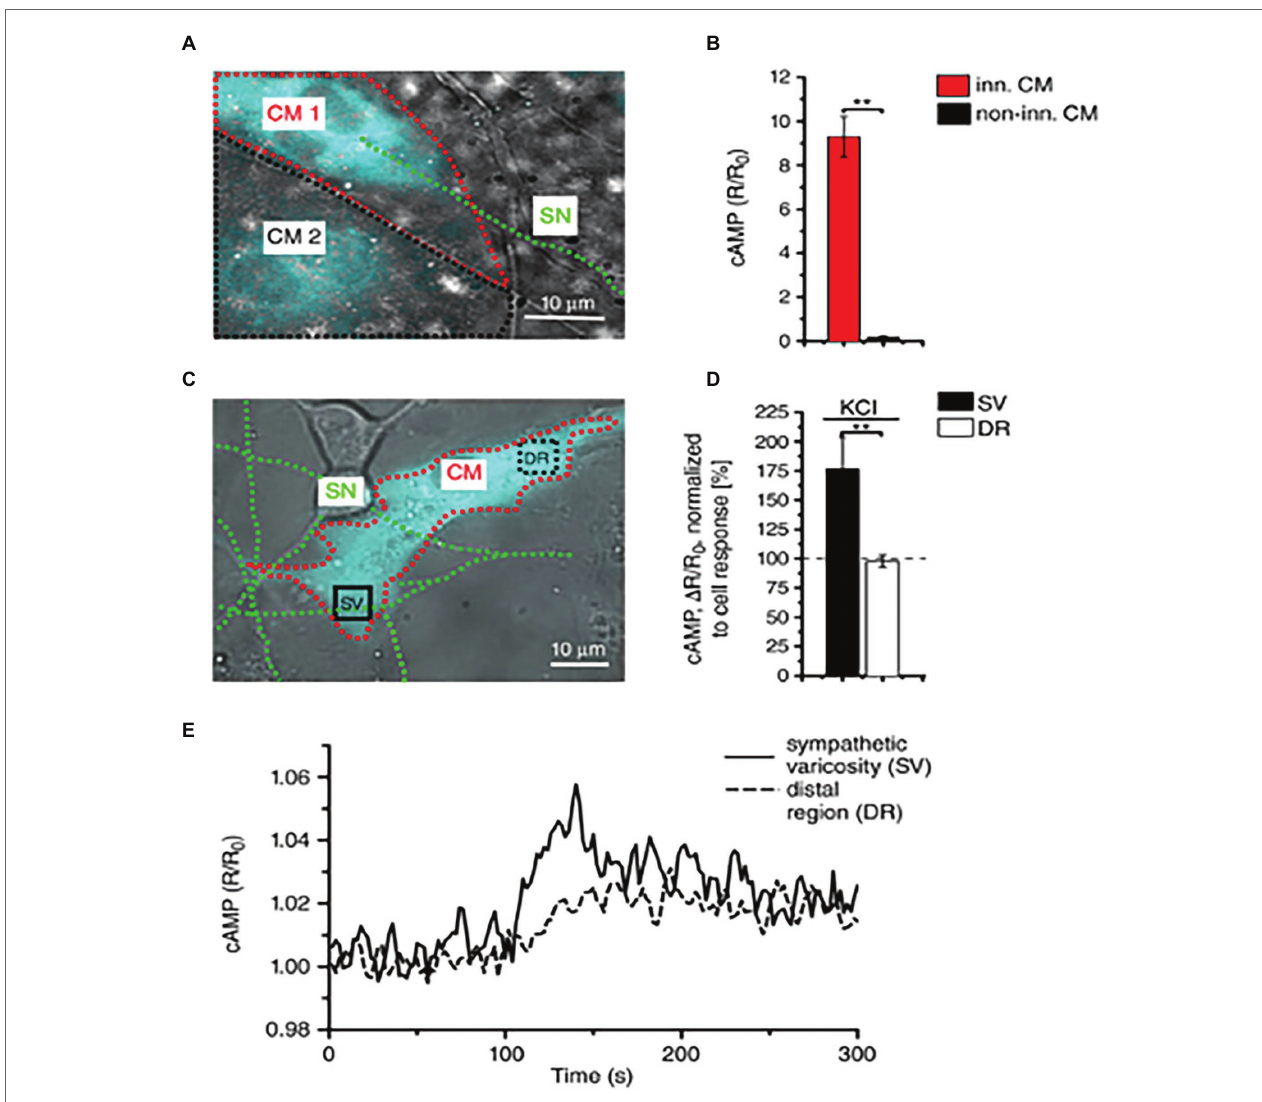
FIGURE 6 | Local activation of cardiomyocytes by innervating neurons. (A) Fluorescence image of two adjacent H187-expressing CMs, one of which (CM1, red line) is in direct interaction with a SN (green line), while CM2, highlighted by a black line, is not innervated. (B) Statistics of cAMP responses to KCl stimulation of SNs, in innervated vs. non-innervated CMs. Bars indicate SEM (** p < 0.01; n = 70 CM per group). (C) Fluorescence image of a H187-expressing CM innervated by SN processes. cAMP variations were evaluated in the CM delineated by a red line, in regions close to (SV) or far from (DR, distal region) the neurocardiac interaction site. Green line highlights the innervating neuron. (D) Statistics of subcellular cAMP variations elicited by neuronal activation in the SV and DR of n = 36 CMs with similar neurocardiac arrangements as in (C) ; bars indicate SEM (** p < 0.01). (E) Representative trace of cAMP changes calculated in the SV and DR regions of the CM shown in (C) . Modified with permission from Prando et al.